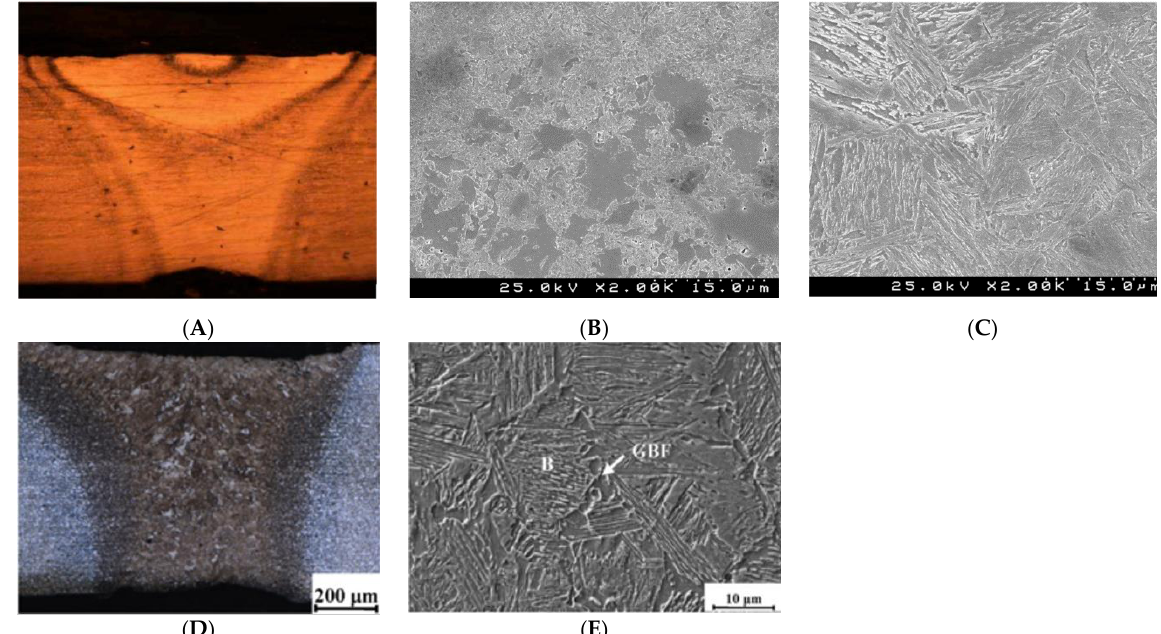
Figure 8. Pulsed laser weldments made of dual phase steels: DP1000 ( A ), and its HAZ ( B ) and FZ ( C ) [56]; DP 590 joint ( D ), and its FZ ( E ) [11].